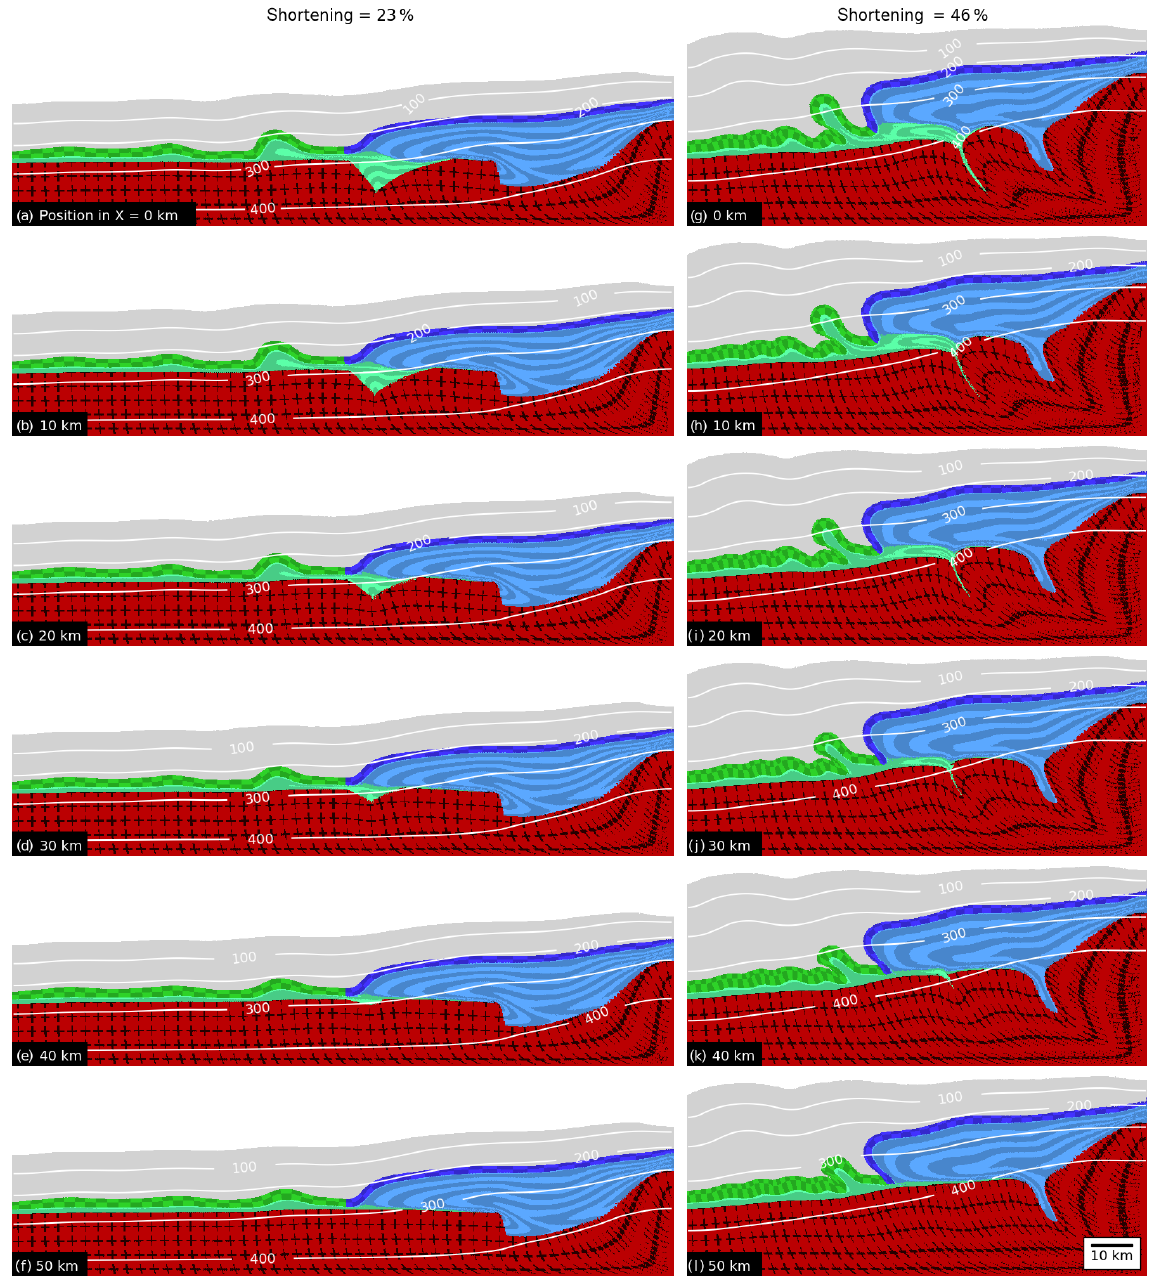
Figure 10. Graph showing lateral cross sections for two different states of bulk shortening for the geometrical evolution of model C.G-1. Cross sections are taken in 10km steps from X = 0 to X = 50km. Additionally, we display the isothermal lines in degrees Celsius ( ◦ C). Columns correspond to the bulk shortening state and rows to cross-section X